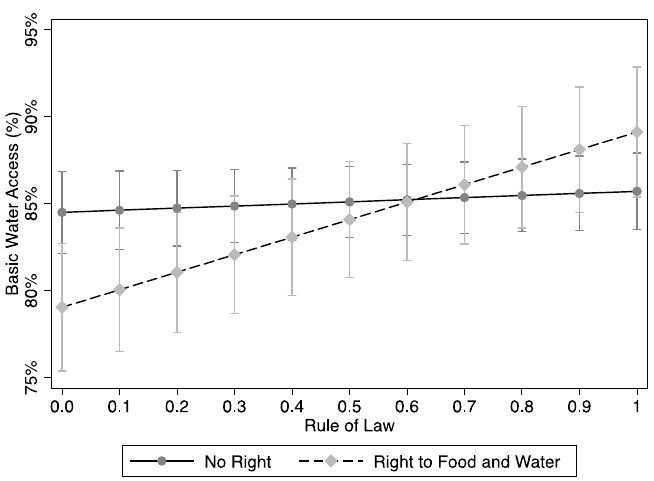
Figure 2. Marginal Effects of Rule of Law and Right to Food and Water on Access.